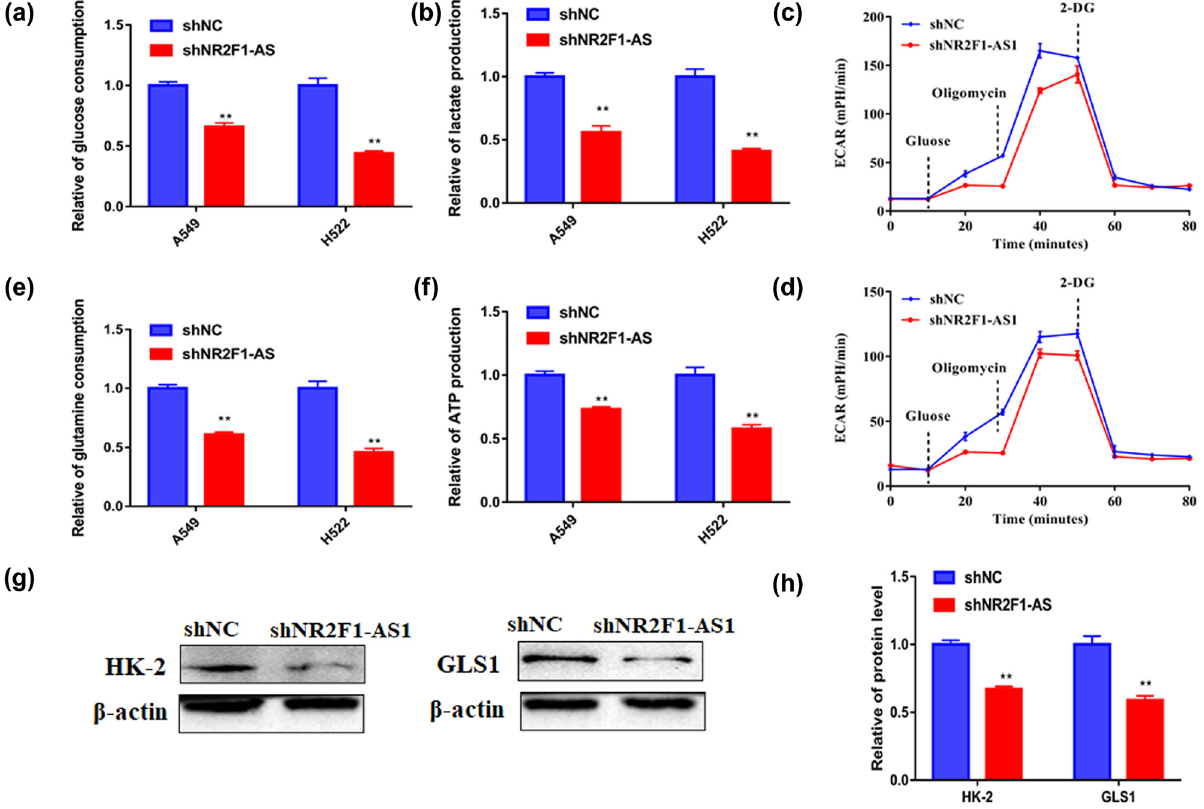
Figure 3: NR2F1 - AS1 silencing limited the NSCLC cells ’ glycolysis and glutamine metabolism. A549 and H522 cells were transfected with sh - NC or sh - NR2F1 - AS1. ( a – d ) The glucose consumption, lactate production, and ECAR were quanti fi ed to assess cell glycolysis. ( e and f ) Glutamine consumption and ATP release were determined by the corresponding assay. ( g and h ) Western blot analysis was presented to assess HK - 2 and GLS1 expression. ** P <